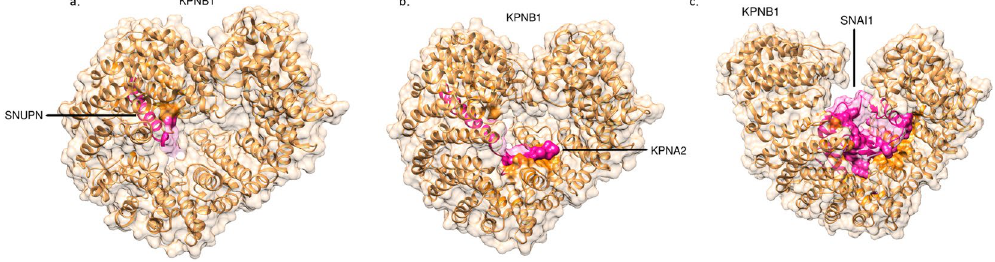
Figure 9. KPNB1 complex structures with. ( a ) SNUPN (PDB ID 3lwwCD) ( b ) KPNA2 (1qgkAB), and ( c ) SNAI1 (3w5kAB). The binding residues on the surface are indicated as opaque.